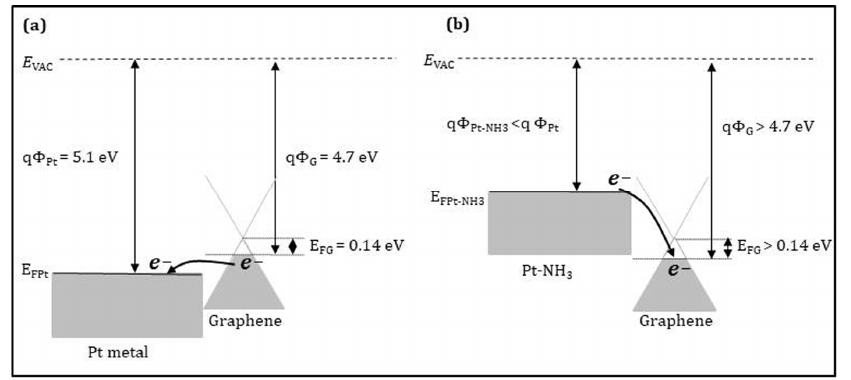
Figure 10. Energy band diagrams ( a ) for Pt and p -type graphene and ( b ) for Pt-NH 3 phase and p -type graphene. E VAC , Φ Pt , E FPt , Φ G , E FG , Φ Pt-NH3 indicate the vacuum energy, Pt work function, Pt Fermi level, graphene work function, graphene Fermi level, and Pt-NH 3 work function, respectively.